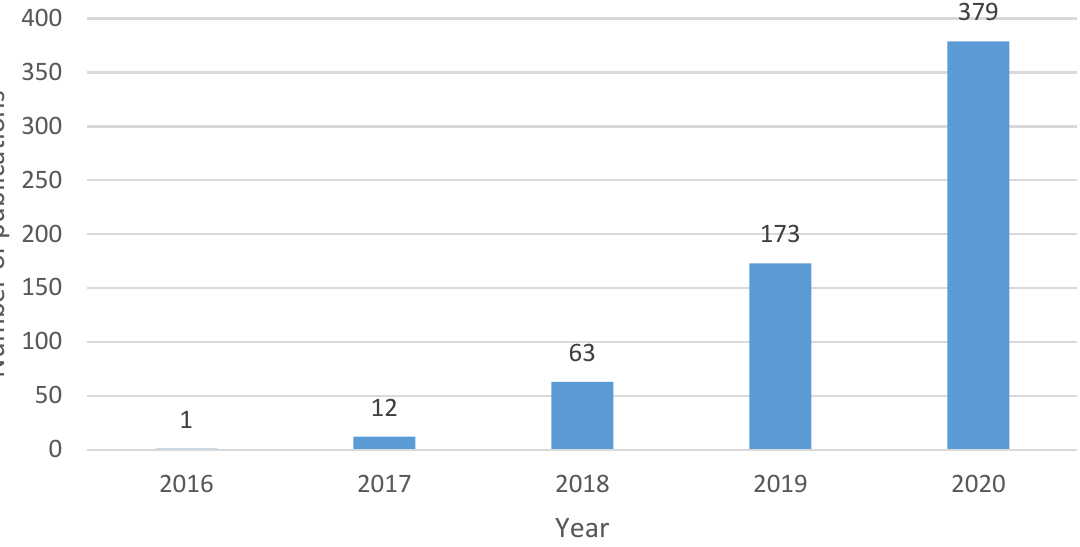
Figure 3. Blockchain research in the field of logistics and SCM.